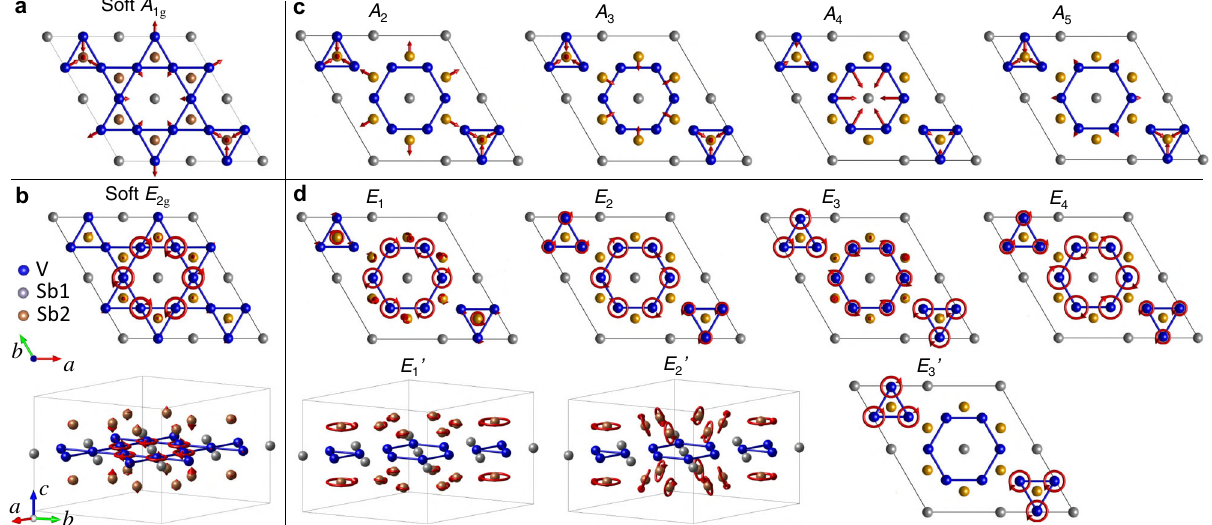
Fig. 4 Real space displacement patterns of the imaginary soft modes and the stable CDW-induced Raman modes in the 2 × 2 × 1 ISD phase. a , b Soft modes with A 1g and E 2g symmetries, respectively. c , d CDW-induced A 1g and E 2g stable modes. The E 2g modes are pairs of chiral phonons and only one chiral mode is shown. The radius of the circles represents the amplitude of the vibration, and the arrow on the circles stands for the initial phase of the vibration. Cs atoms are omitted in the crystal structure for clarity, because they do not contribute to lattice